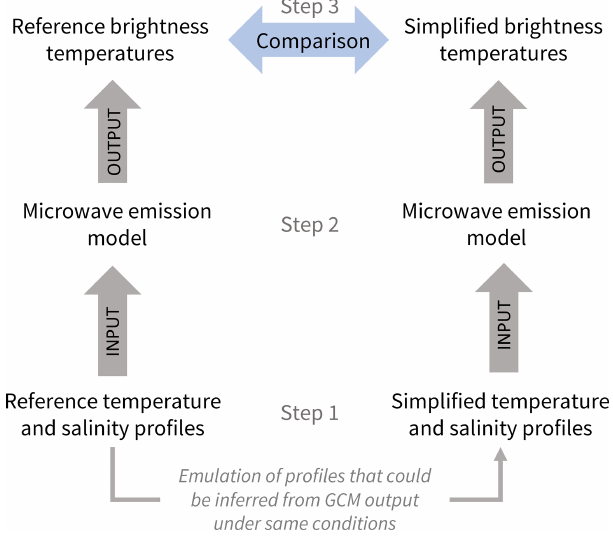
Figure 1. Schematic of the steps of our simulation and comparison